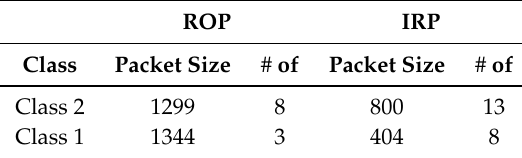
Table 7. ALD-SC Packet sizes and number of packets per packetisation